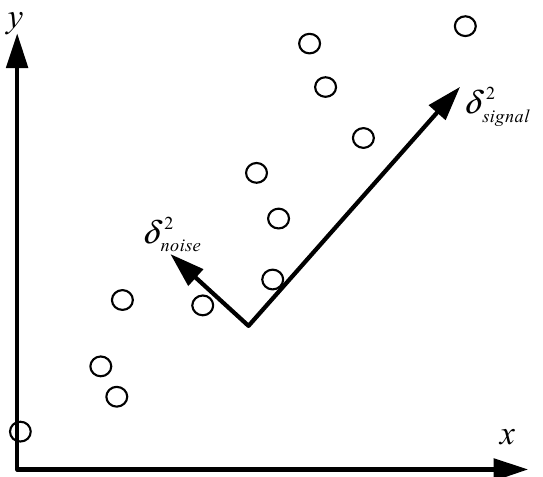
Figure 7. Signal to noise ratio.